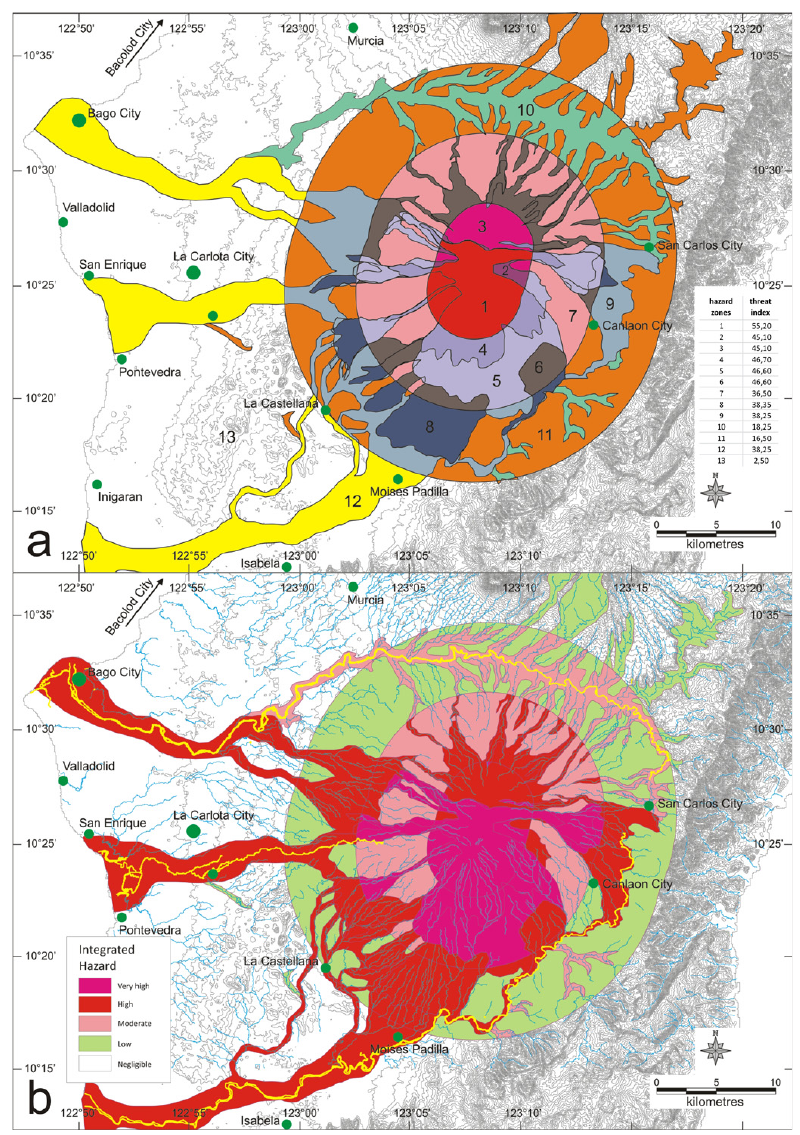
Fig. 8. Multi-hazard map of Kanlaon. (a) Preliminary map obtained by overlapping the values of threat index for each phenomenon in different sectors of the analysed territory. (b) Final multi-hazard map obtained by grouping the threat indexes into five classes. See text for explanation. Blue lines represent the drainage system (in yellow are the main rivers potentially affected by huge lahar and mudflow deposits).